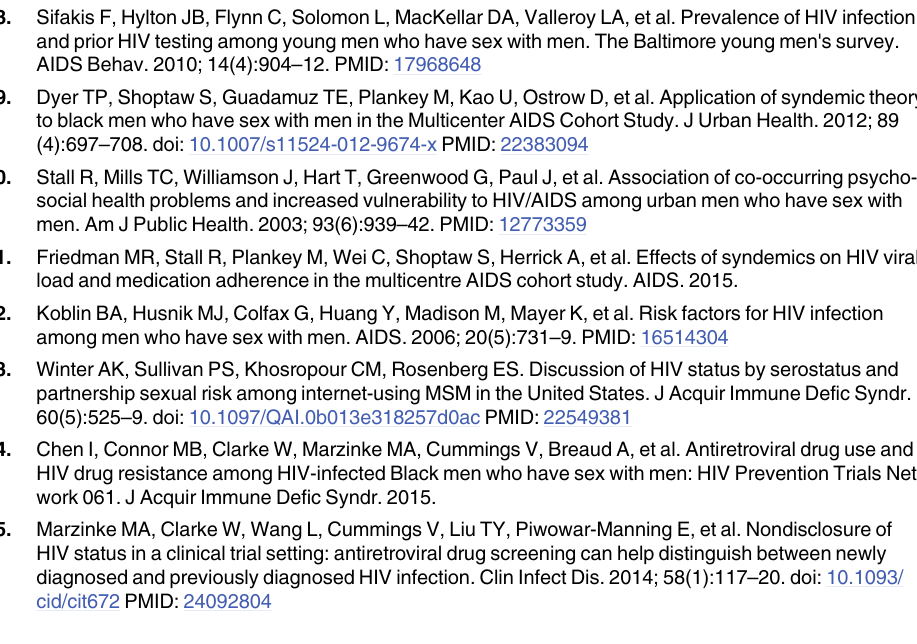
PLOS ONE | DOI:10.1371/journal.pone.0134085 August 4,